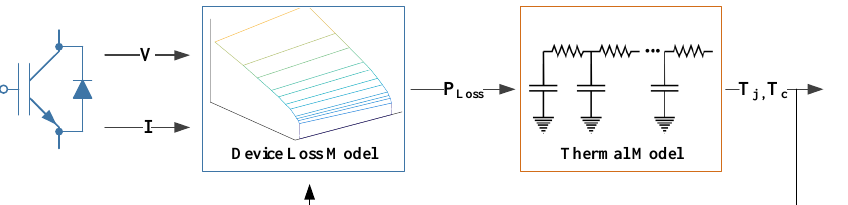
Figure 8. Closed recursive loop for determining the semiconductors’ junction temperature.